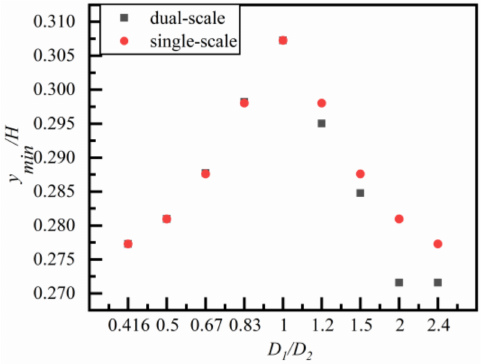
Figure 14. Changes in the equilibrium position of the smaller